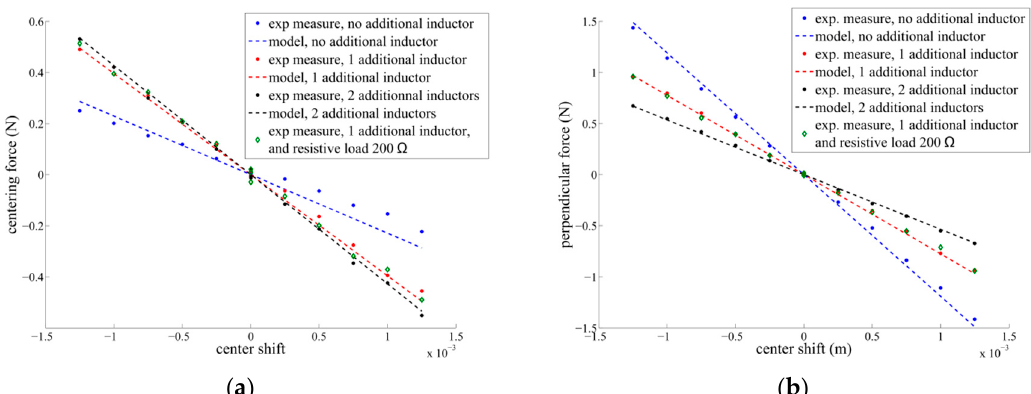
Figure 19. ( a ) Restoring force and ( b ) destabilizing bearing forces as a function of the rotor displacement along the x-axis while centered along the y-axis for a spin speed of 4800 rpm. Measures with and without additional inductors when the generator is left in open circuit and when connected to a 200 Ω charge, and comparison to the model when its parameters are identified by curve fitting.